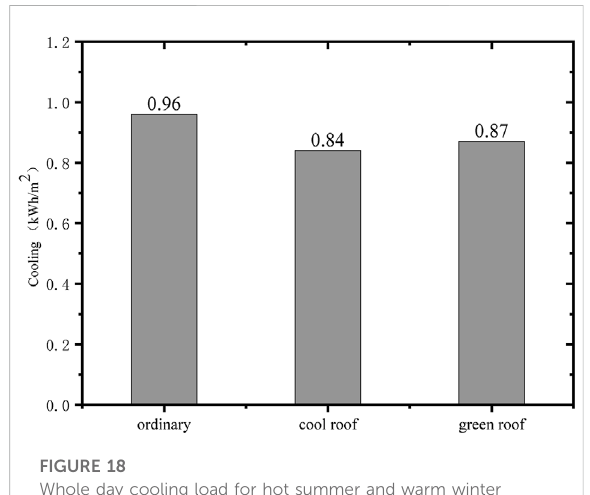
FIGURE 17 Cooling rate under different roofs in hot summer and warm winter zones.